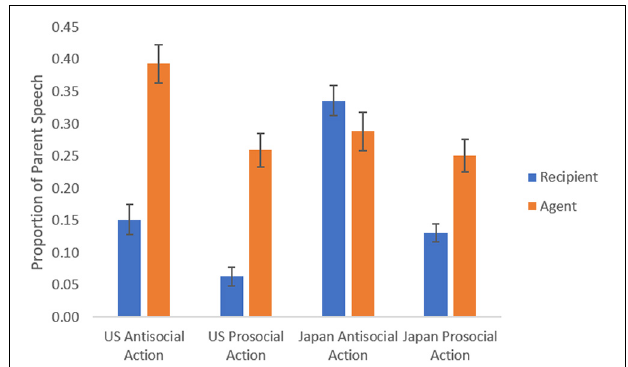
FIGURE 1 | Moral attentional foci in parental narratives as a function of moral scenario. Error bars represent the ± 1 standard error (SE).